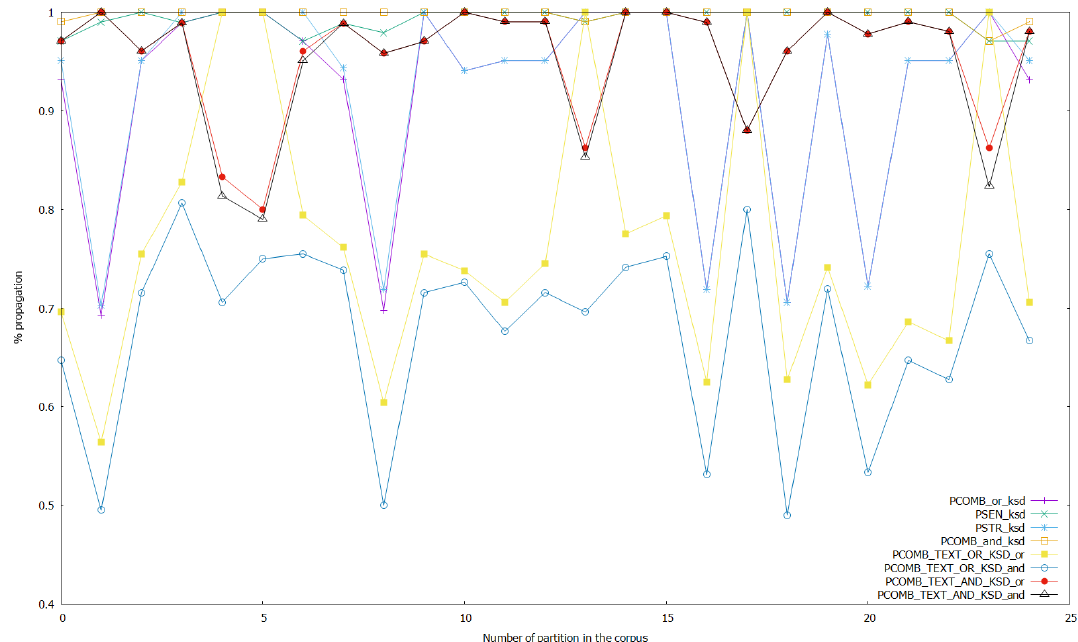
Figure 11. Results of the experiments with the sentiment, stress, and combined analyses on keystroke data, and with the combined analyses on text and keystroke data with threshold set to 0.7 in the ANNs that perform sentiment